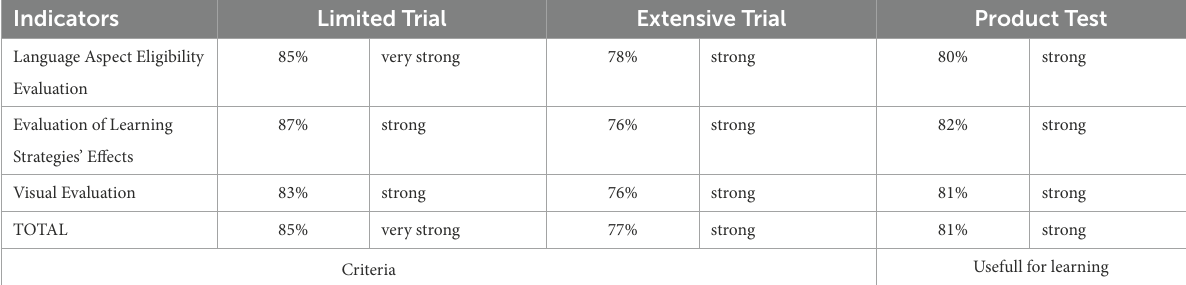
TABLE 8 Recapitulation of student response results.